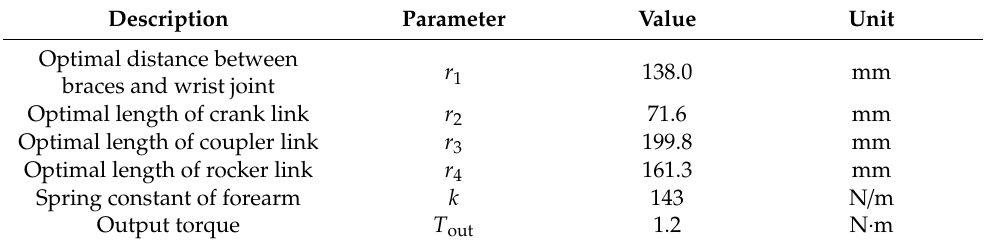
Table 2. The optimal and constant values of parameters used in